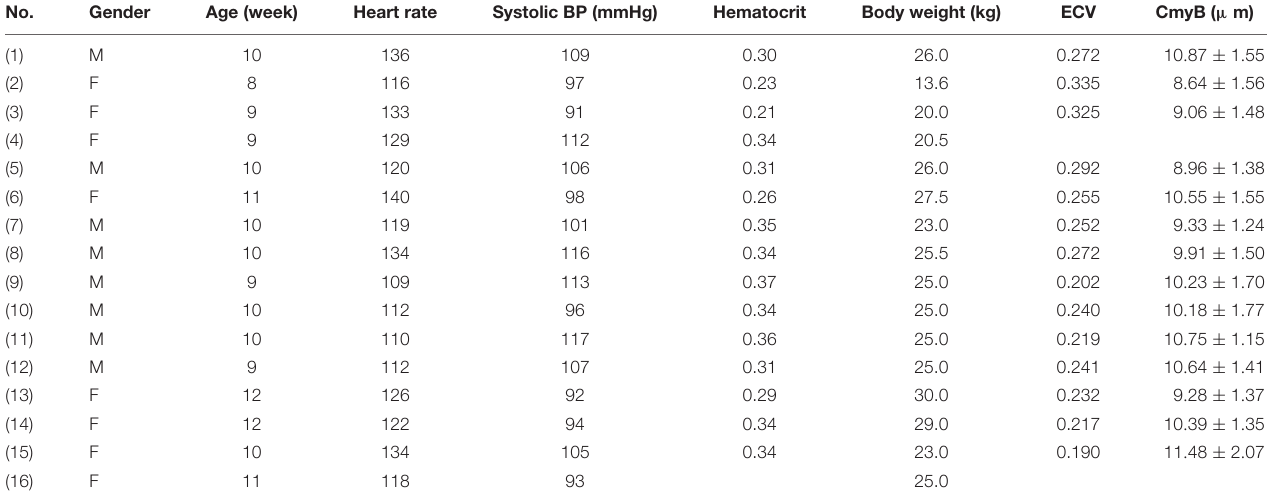
TABLE 1 | Animal characteristics and individual data.